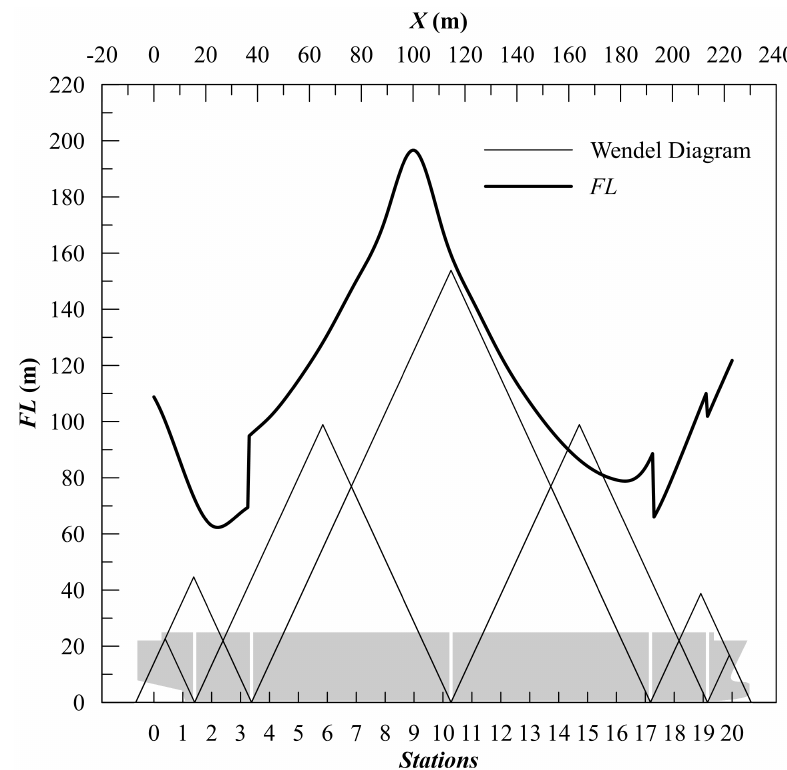
Figure 8. Equispaced subdivision: 2 cargo hold case.